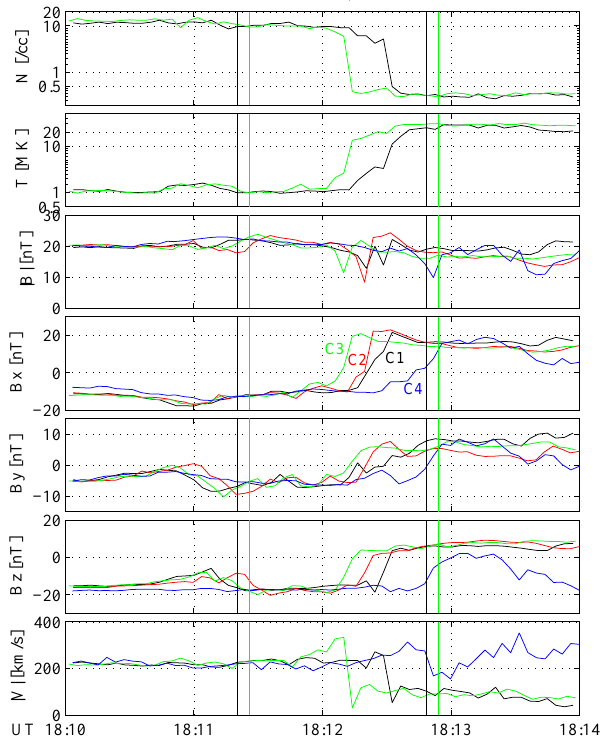
Fig. 1. Time series of Cluster measurements around a magne- topause crossing event occurring at ( − 7.89, − 17.11, 3.25) R E in GSE on 30 June 2001. The panels, from top to bottom, show ion number density, ion temperature, intensity and three components of the magnetic field in GSE coordinates, and ion bulk speed, respec- tively (black: spacecraft 1 (C1), red: C2, green: C3, blue: C4). The interval enclosed by the two black vertical lines is used in the recon- struction based on C1 data, while that enclosed by the green lines is in the reconstruction based on C3 data.